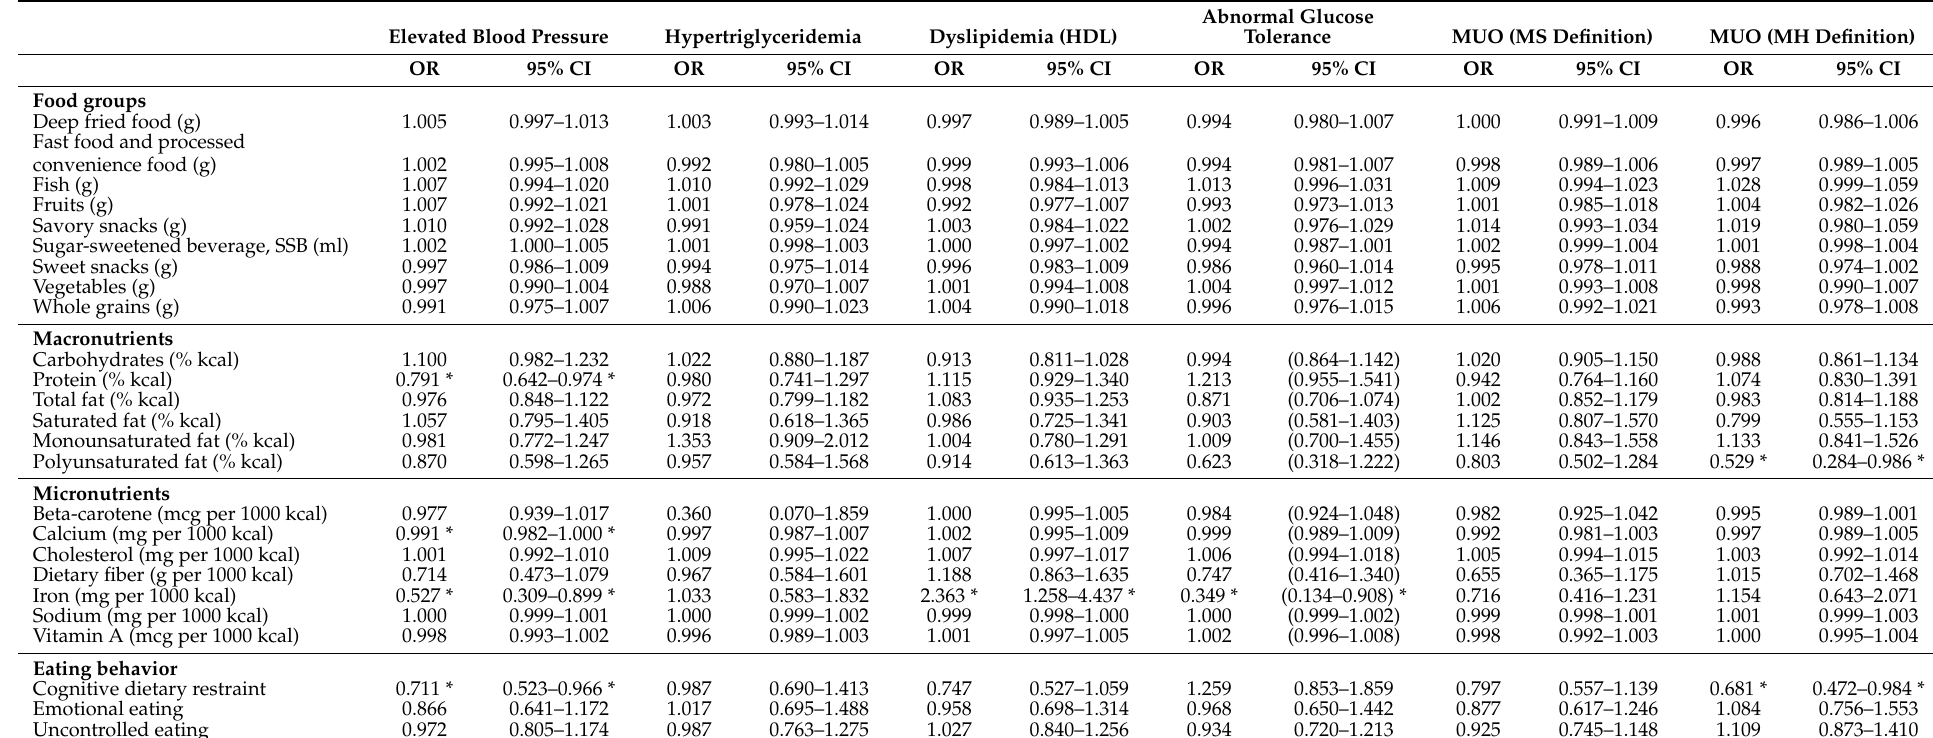
Table 6. Nutritional factors predictive of metabolic